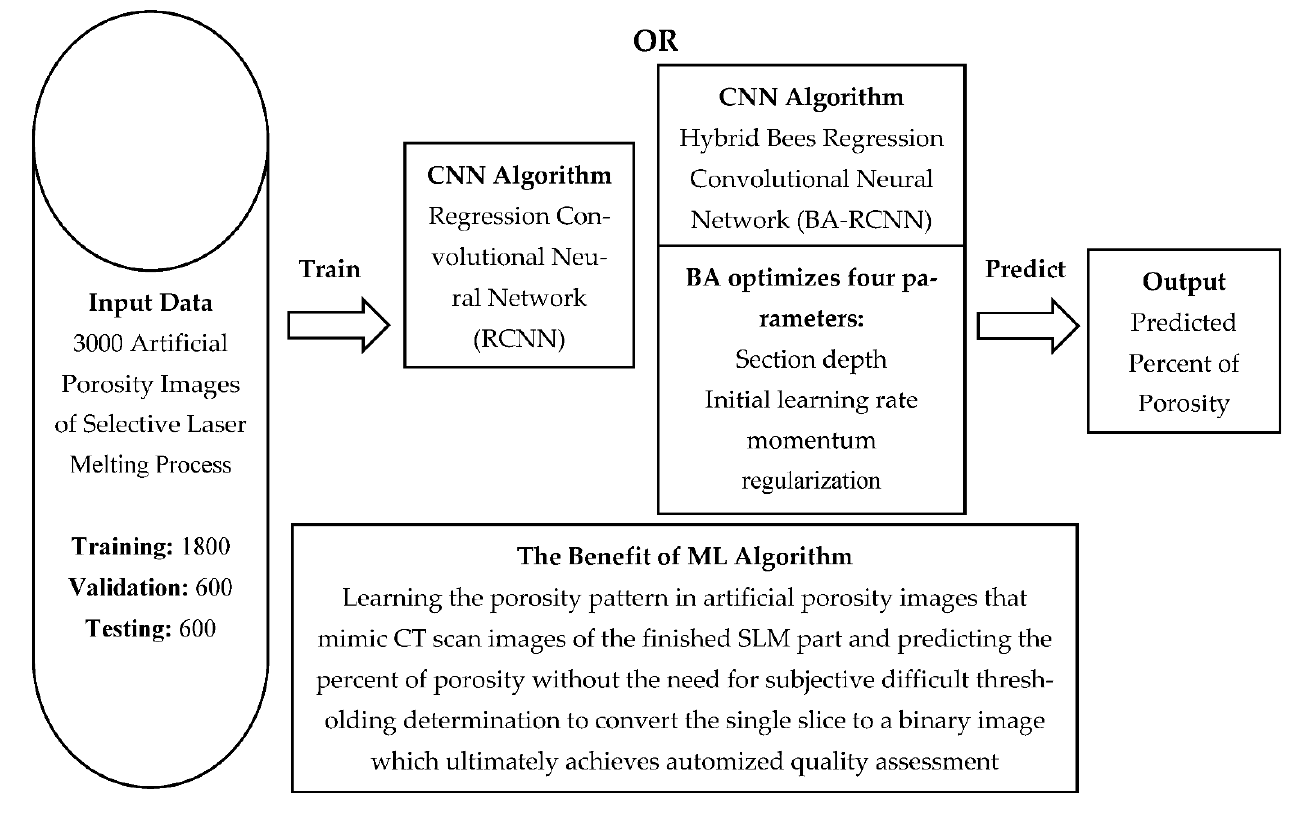
Figure 27. Illustrative diagram for hybrid regression CNN.